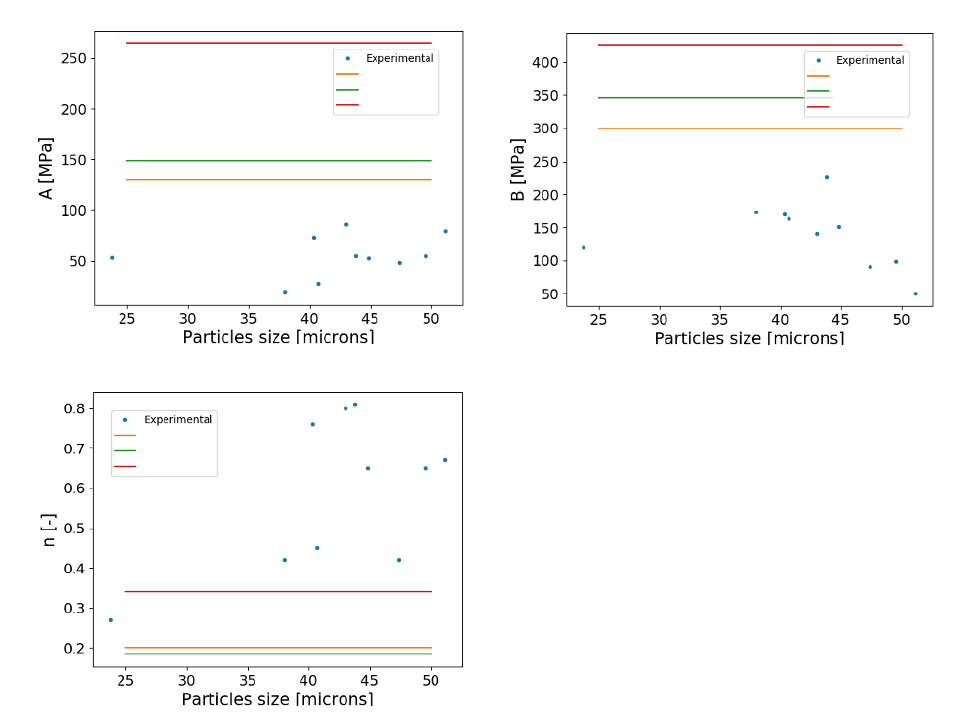
Fig. 3. Best fitting parameters as a function of particle size. Points represent values obtained in this study for different powders. Lines report literature values, from [17-19].